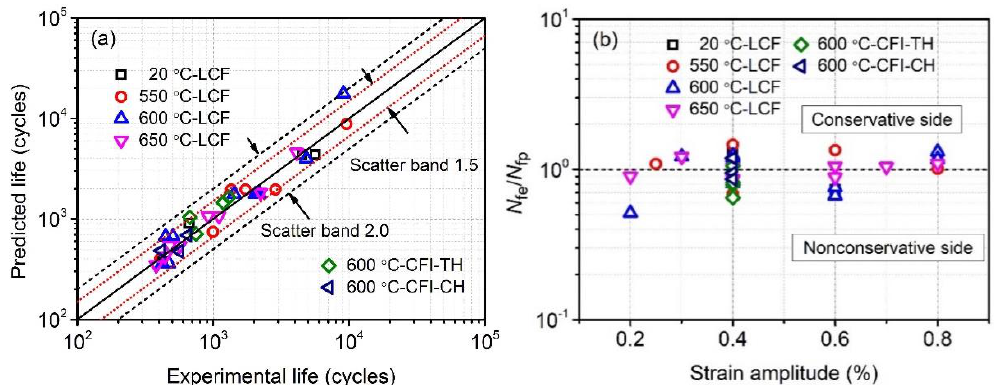
Figure 9. ( a ) Comparison between experimental life and predicted life using MMCB model, ( b ) the ratio of experimental life to predicted life versus different strain amplitudes. Table 6. Parameters required for the fatigue life prediction in various models.